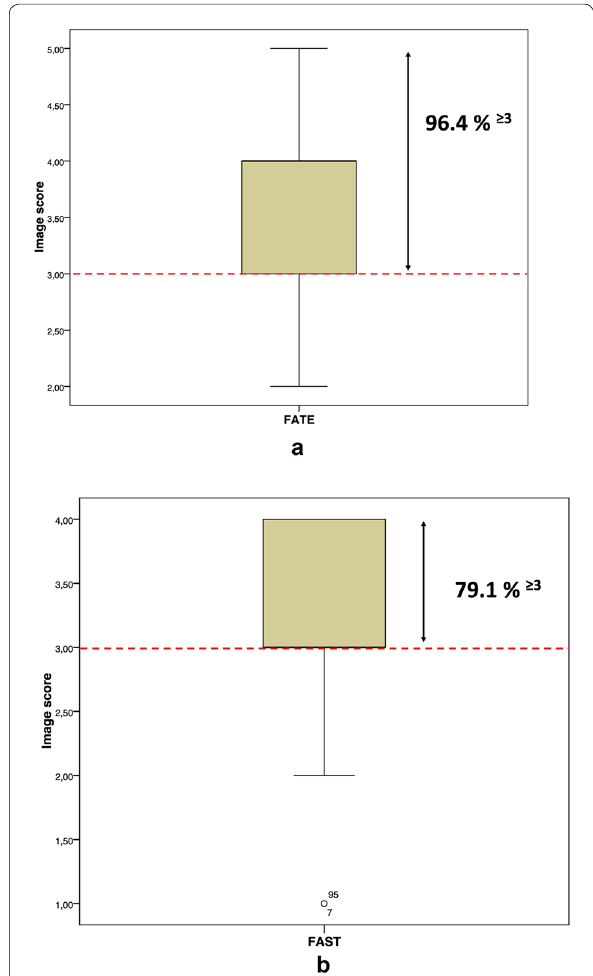
Fig. 4 a FATE. Box plot showing the median value, interquartile range, and minimum and maximum values. The box plot is dichotomized by the red dotted line with a score of that clinically useful information could be extracted from the video clips. Of all images from telementored FATE, 96.4% had a quality score of 3 or higher (% ≥ 3 ). b FAST. Box plot showing the median value, interquartile range, and minimum and maximum values. The box plot is dichotomized by the red dotted line, with a score of that clinically useful information could be extracted from the video clips. Of all images from telementored FAST, 79.1% had a quality score of 3 or higher (% ≥ 3 ). Two defined outliers had an image score of 1